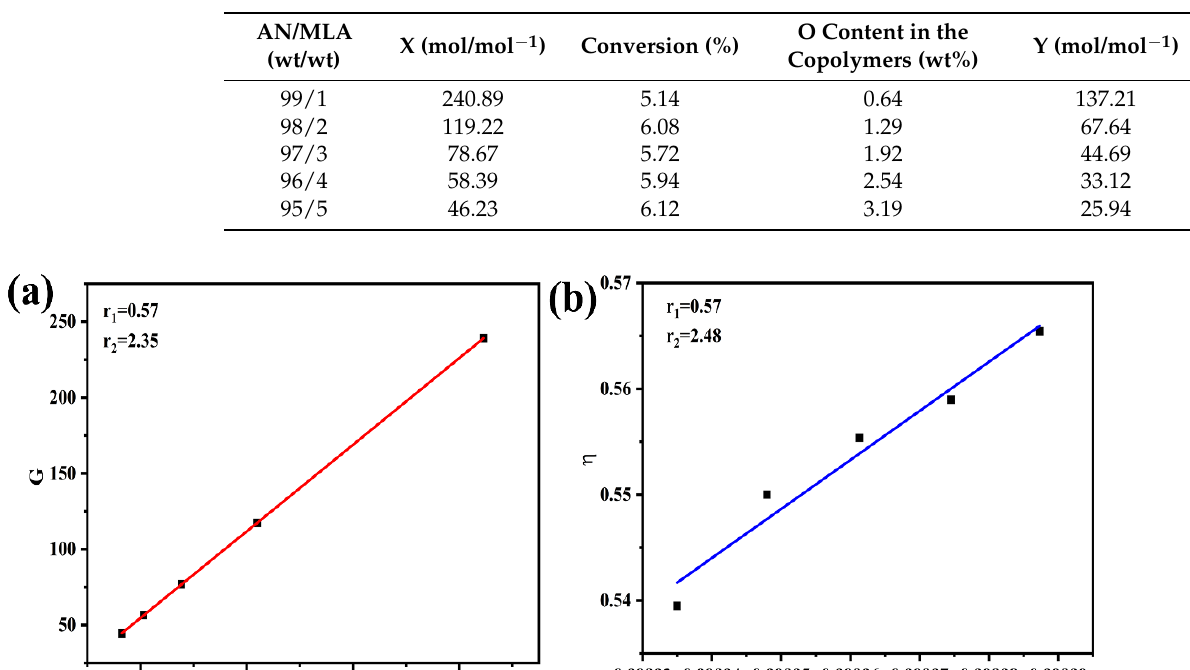
Table 1. Parameters for mixed solution copolymerization of AN/MLA with low conversion.